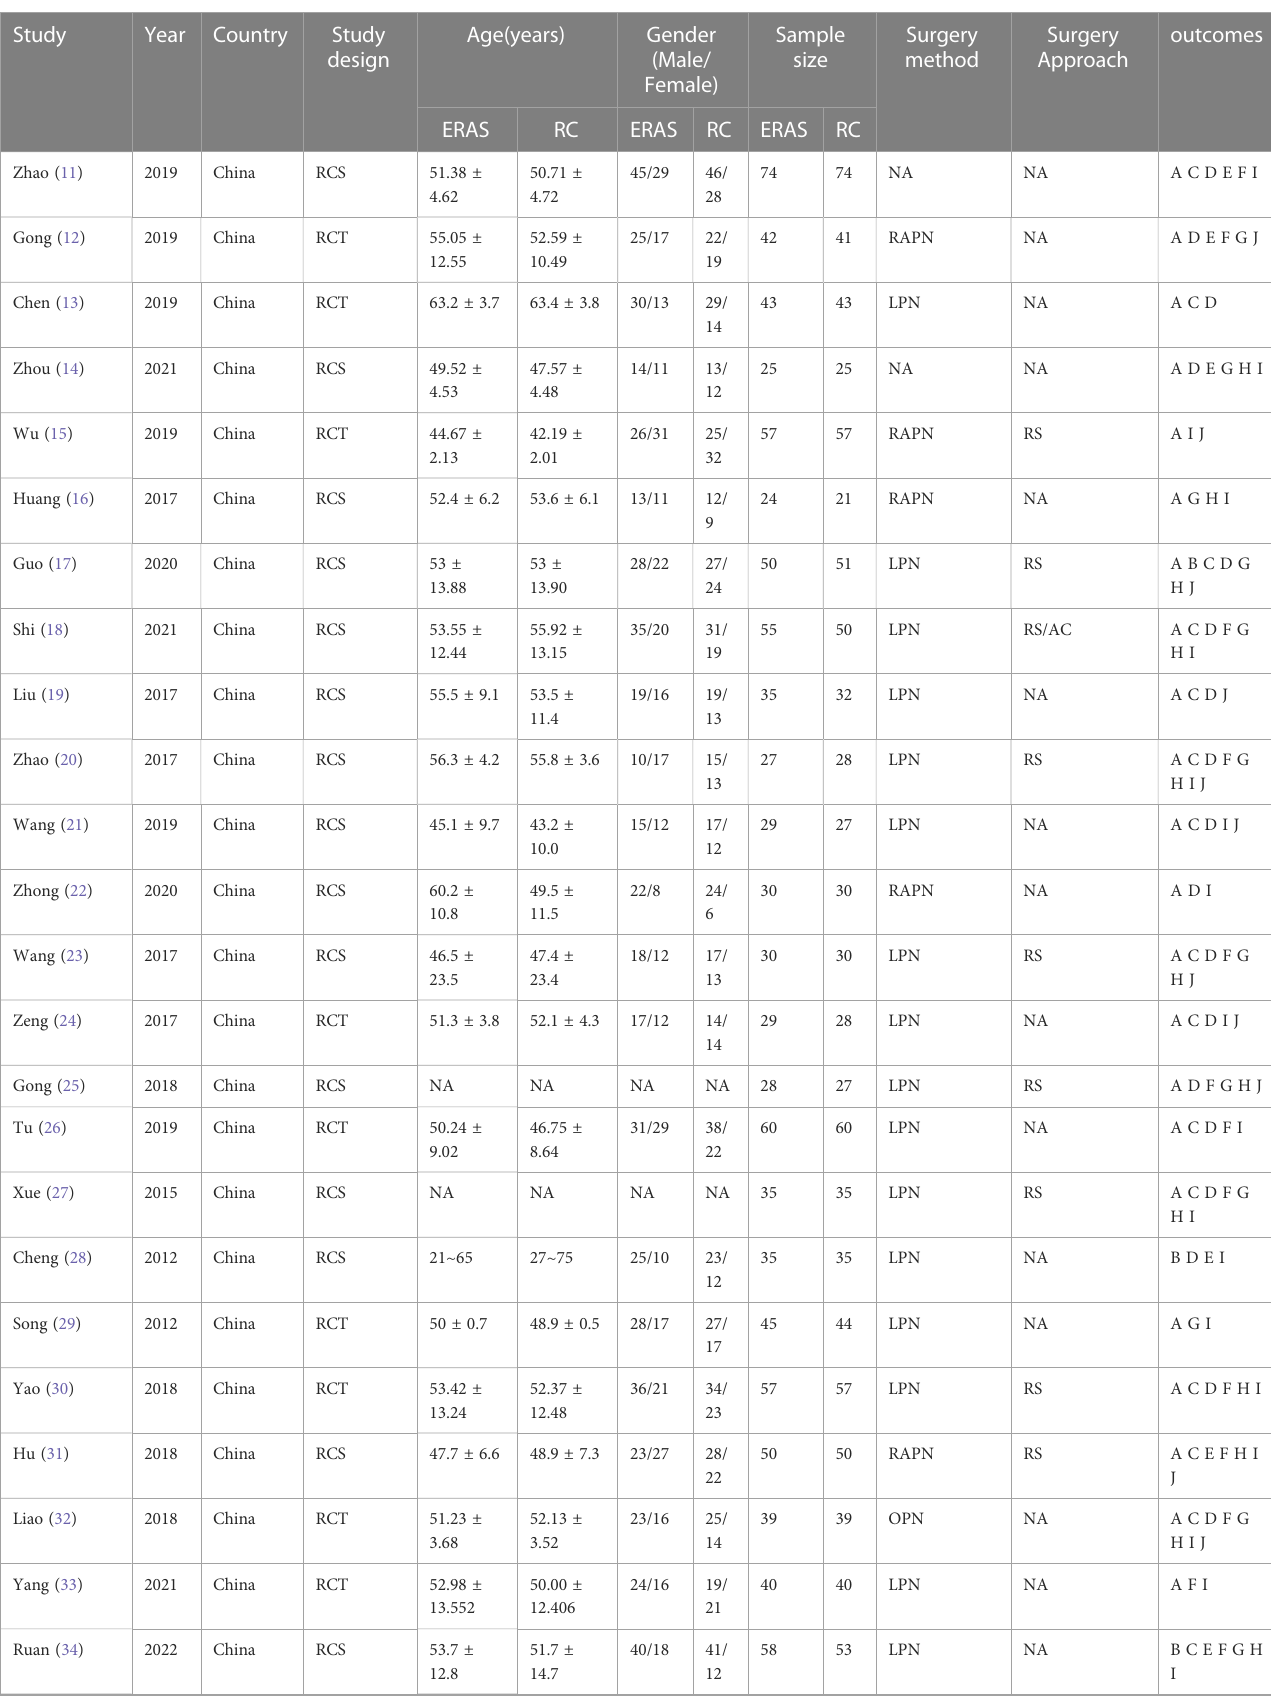
TABLE 2 Basic characteristics of the included